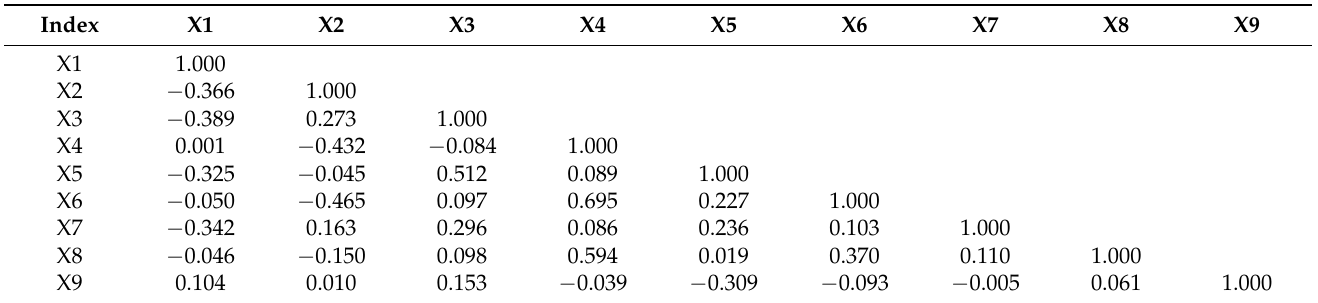
Table 2. Pearson correlation coefficient matrix of each